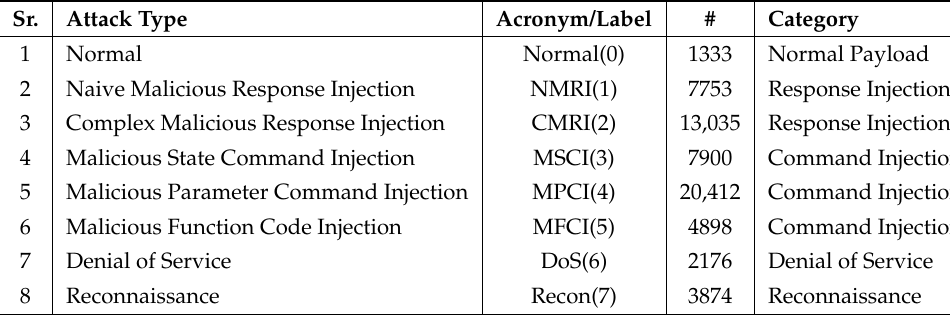
Table 2. Types and categories of attacks present in the dataset. Sr.